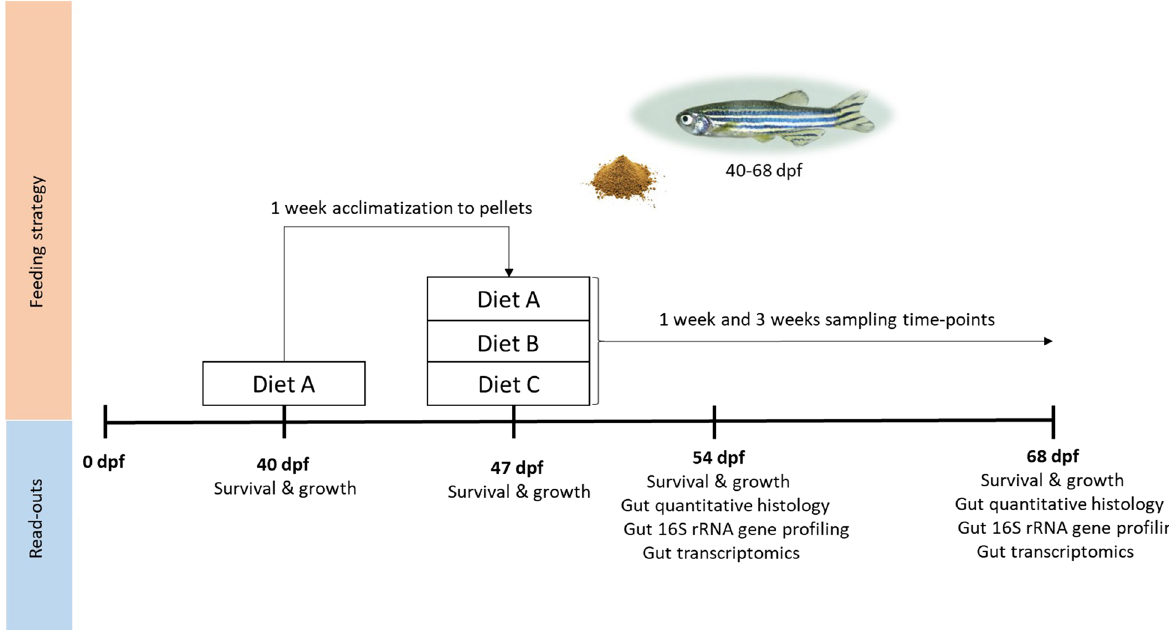
Fig. 1 Experimental design. Fish were bred and raised as described in the section ‘Zebrafish and diets’. At 40 dpf (juvenile stage) they were fed diet A for 1 week for acclimatisation to dry feed pellets. At 47 dpf, fish were randomly distributed into tanks and fed one of the diets (A, B or C) for 3 weeks. Survival and growth were measured before and during the whole experiment. After 1 week (54 dpf) and after 3 weeks (68 dpf) of feeding the fish. Gut samples were collected for histological, metatranscriptomic and microbiome